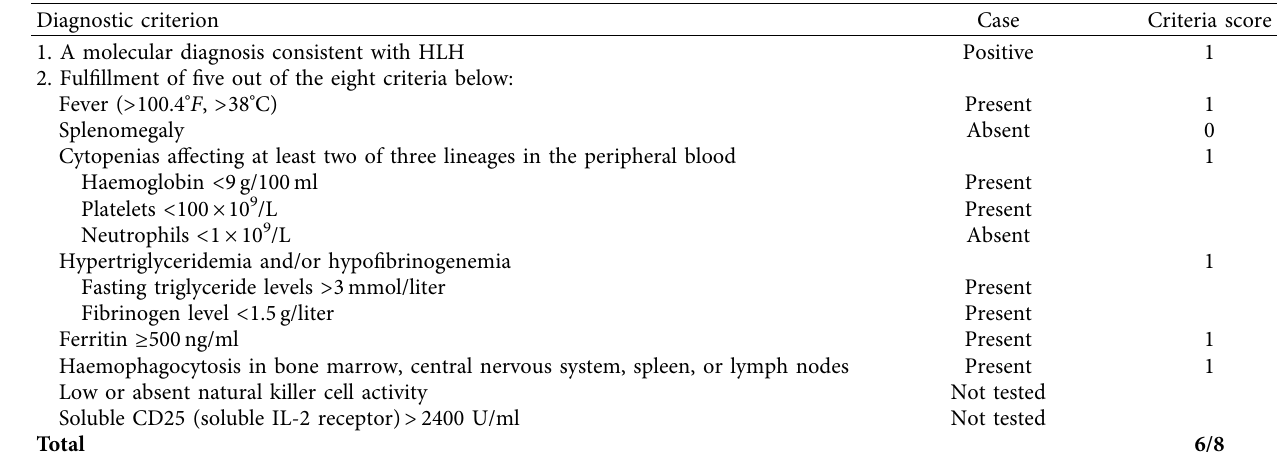
Figure 1: Haemotoxylin and eosin stained bone marrow trephine (x60) showing erythroid hyperplasia, normal megakaryocytes, and a subtle infiltrate of small lymphocytes and histiocytes. Table 2: Diagnostic criteria for haemophagocytic